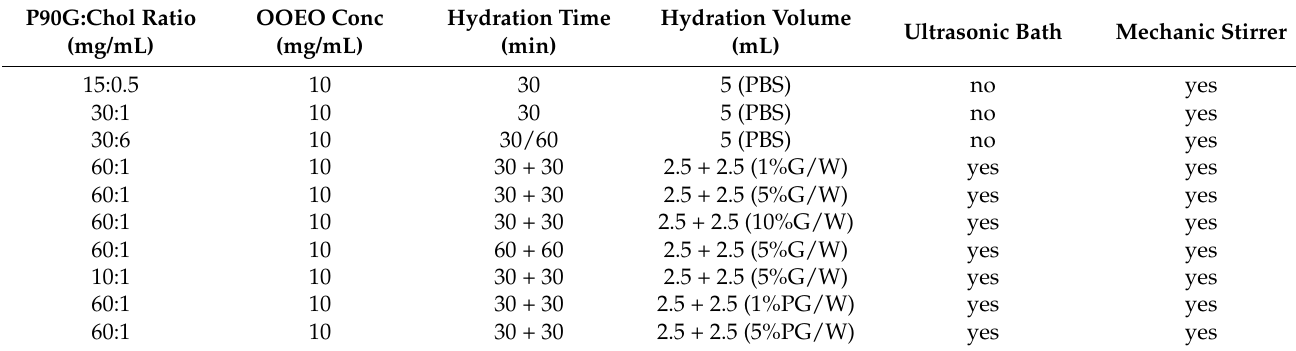
Table 8. Preparation of OOEO-loaded vesicles.